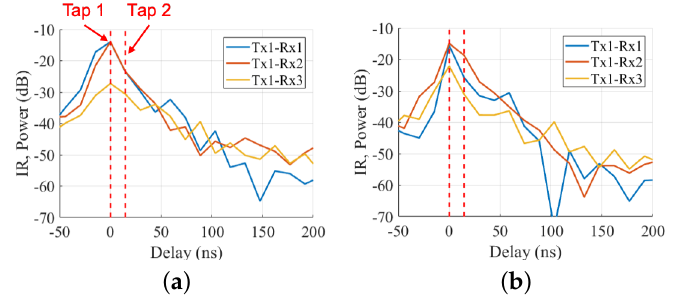
Figure 12. Fluctuation of the impulse response. ( a ) Without a human. ( b ) With a human.